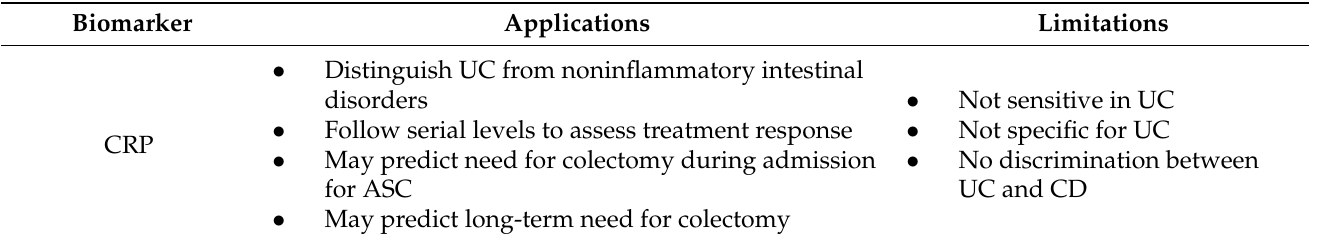
Table 3. Applications and limitations of biomarkers studied in